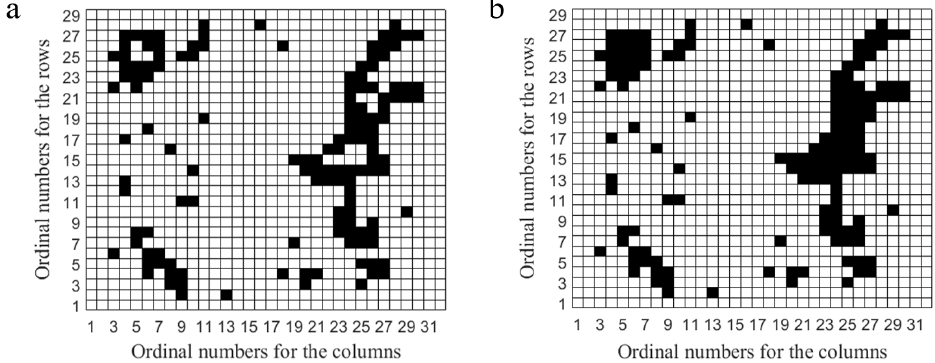
Figure 17. ( a ) Passable grids are shown with white grids. ( b ) The safe zone is shown with white grids.